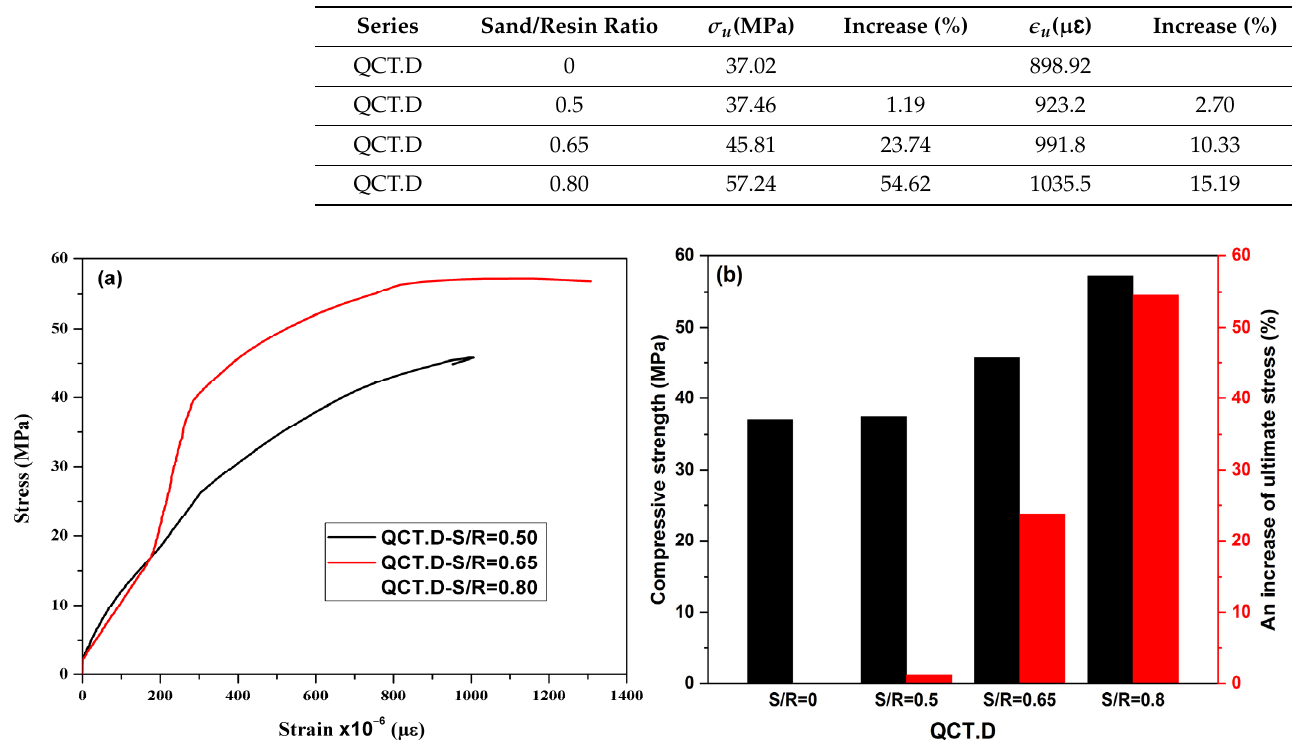
Figure 14. Effect of adding sand to resin: ( a ) stress–strain curve; and ( b ) compressive strength.